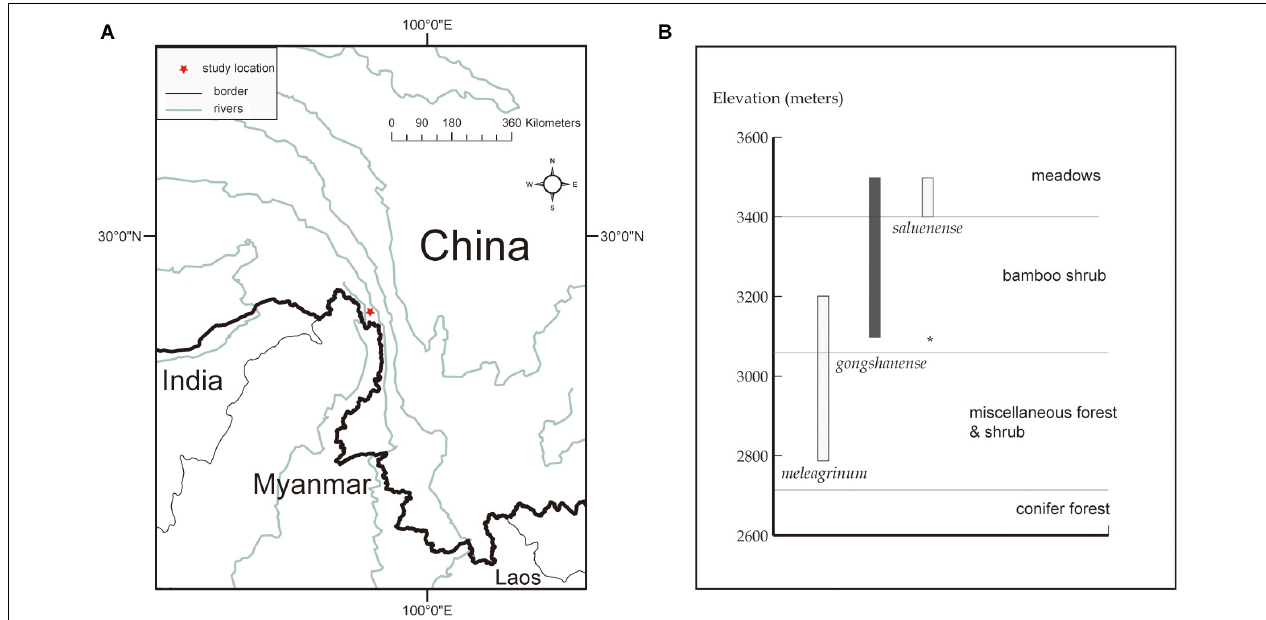
FIGURE 1 | Study location and species distribution information. (A) The red star indicates the research spot located at northwestern Yunnan, China. (B) Elevational range (bars) and vegetation zones inhabited by the three Lilium species of present. Map generated in ESRI ArcGIS 10.0 (ESRI,